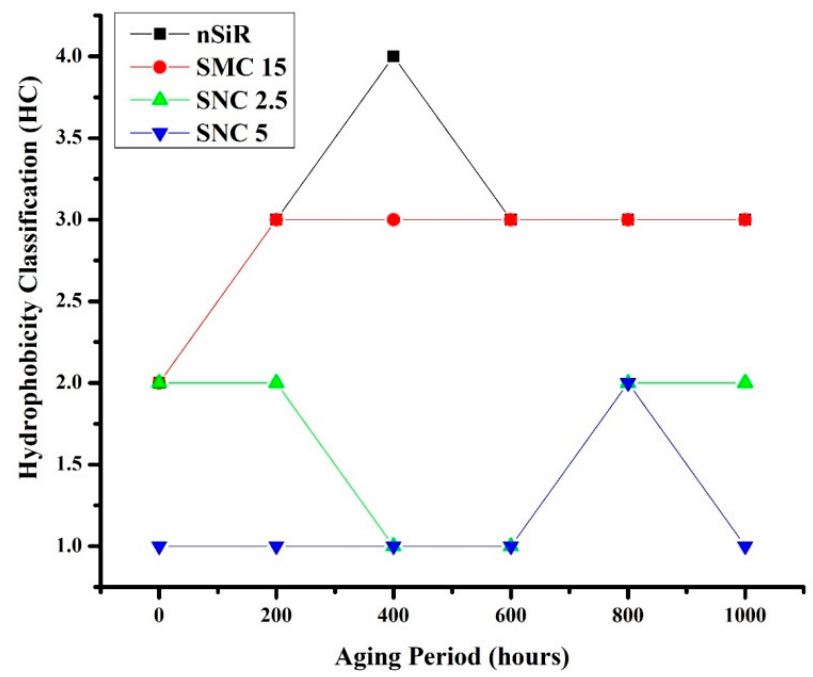
Figure 9. Variation in hydrophobicity with aging time.